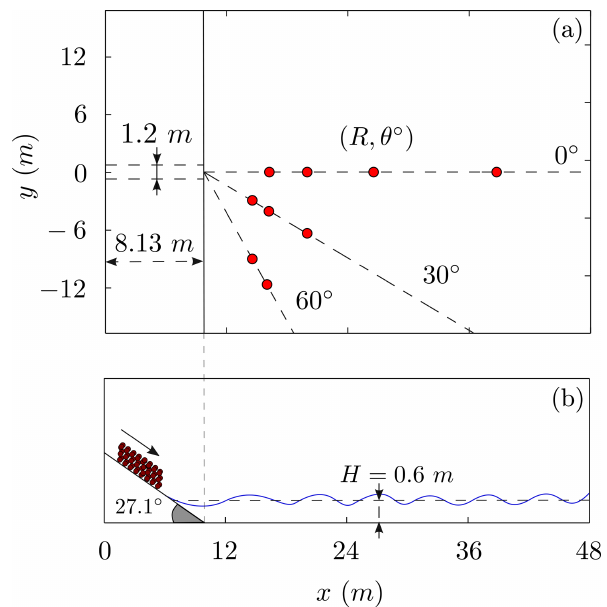
Figure 9. Schematic picture of the computational domain. Plan view in panel (a) . Cross section at y = 0m in panel (b) . The red dots represent the distribution of the wave gauge positions in the laboratory